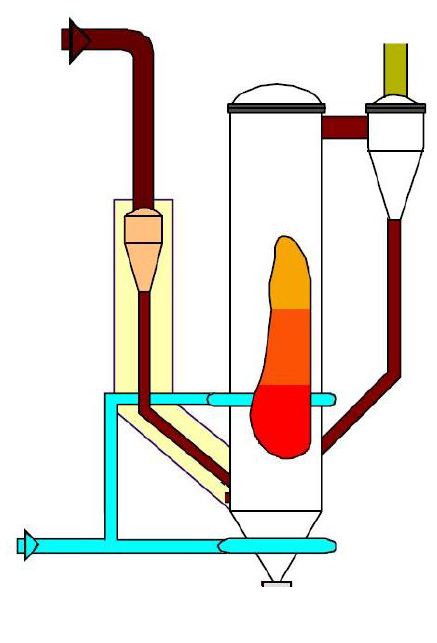
Figure 16. High Temperature Winkler Gasifier [1].